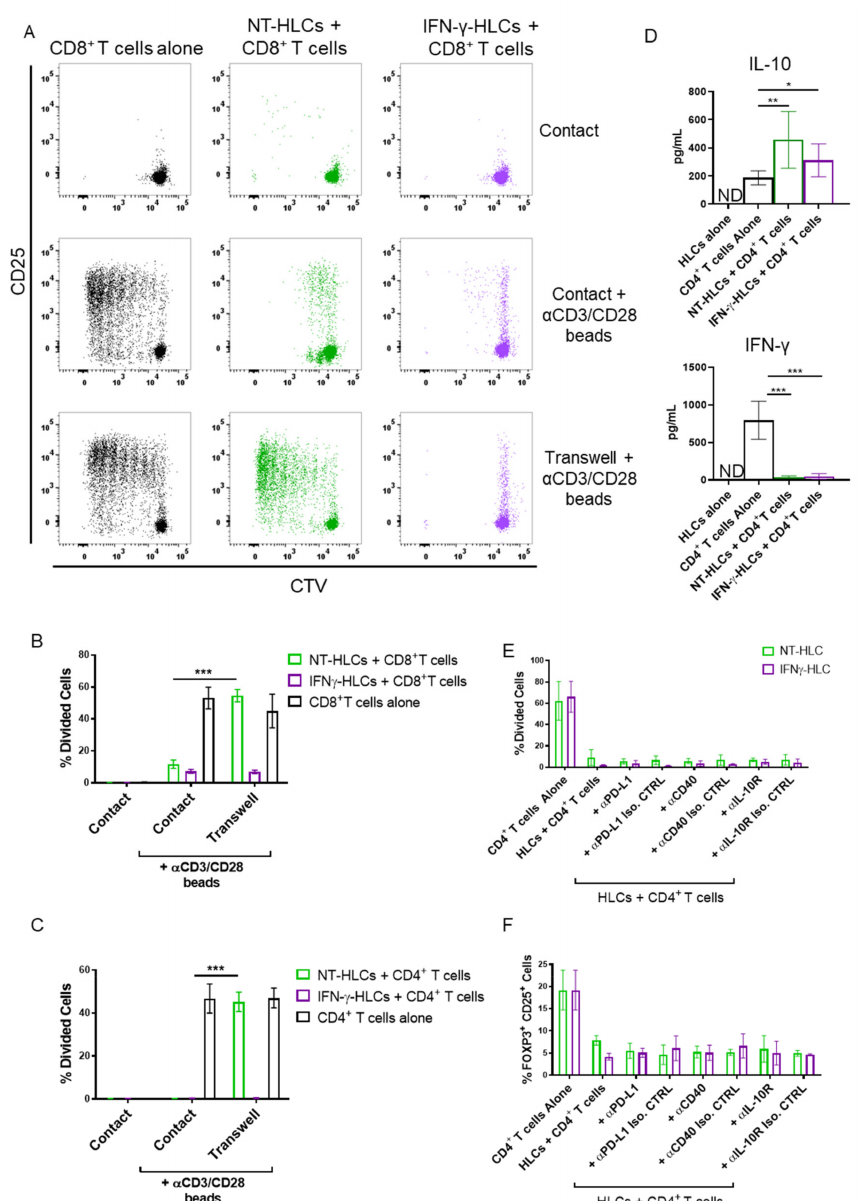
Figure 2. Allogeneic HLCs inhibit T cell activation. CellTrace Violet (CTV)-labelled CD8 + or CD4 + T cells were co-cultured for 5 days with or without α CD3/CD28 beads (bead to cell ratio 1:40) in the absence (alone) or in the presence of HLCs treated or not with IFN- γ (1000 U/mL) in the same wells (contact) or separated by transwells. ( A ) Representative dot plots of CD8 + T cell proliferation and upregulation of CD25 expression. ( B ) Quantification of the percentage of divided CD8 + T cells co-cultured with HLCs. ( C ) Quantification of the percentage of divided CD4 + T cells co-cultured with HLCs. ( D ) IL-10 (upper panel) and IFN- γ (lower panel) production from co-cultures of HLCs and CD4 + T cells. ( E ) Quantification of the percentage of divided CD4 + T cells activated with α CD3/CD28 beads and co-cultured with HLCs in the presence of α PD-L1, α CD40, α IL-10R and cognate isotype controls. ( F ) percentage of CD25 + FOXP3 + in CD4 + T cells activated with α CD3/CD28 beads and co-cultured with HLCs in the presence of α PD-L1, α CD40, α IL-10R-blocking antibodies and cognate isotype controls. * p < 0.05, ** p < 0.01, *** p < 0.001. ( B , C ) Two-way ANOVA. ( D , E ) One-way ANOVA. N.D.: not detected. Data are expressed as mean ± SD of 4 independent experiments, with one donor per experiment, in